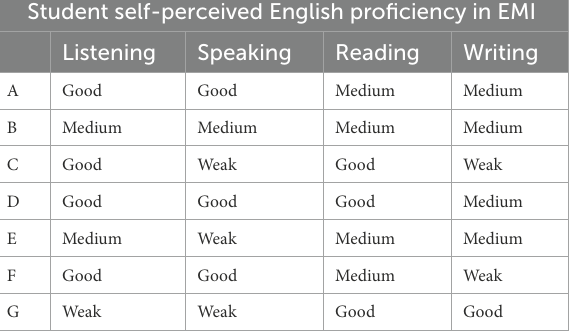
TABLE 3 Students’ self-perceived language